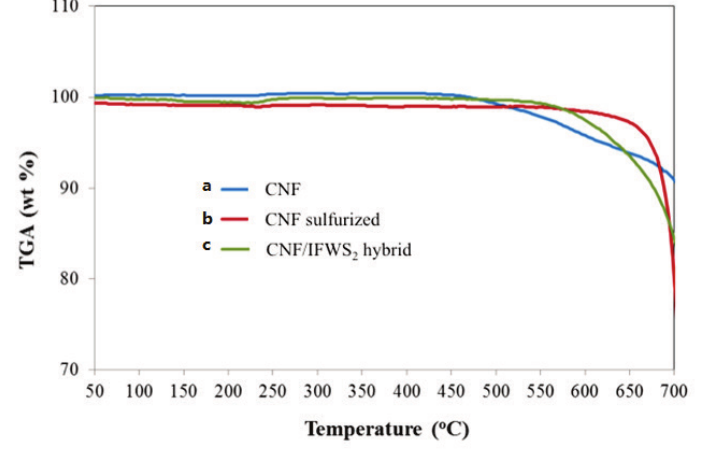
Figure 6. Thermogravimetric Analysis. Temperature programmed oxidation (burn off process) for ( a ) carbon nanofibers-including nickel catalyst; ( b ) sulfurized carbon nanofibers -including nickel sulfide and ( c ) CNF/IF-WS hybrid with 3% tungsten sulfide 2 loading. All of the samples are stable in oxygen containing environment up to 500